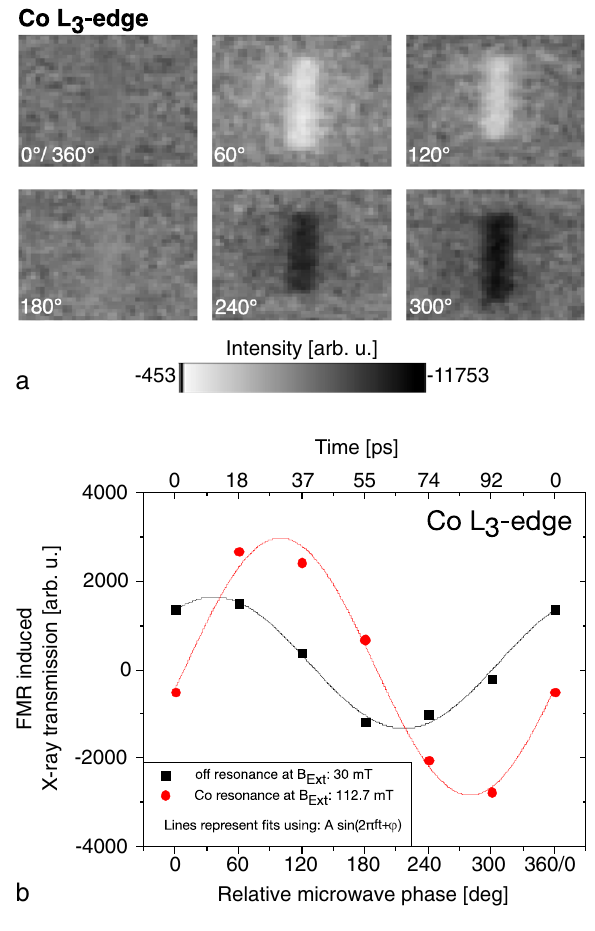
Figure 2. ( a ) 6 STXM-FMR difference images obtained from six microwave on and six microwave off images ◦ recorded every 60 (18 ps) at the Co L 3 -edge at B Ext,3 . ( b ) FMR induced X-ray transmission signal (red dots: at Co resonance 3, black squares: off resonance) as function of